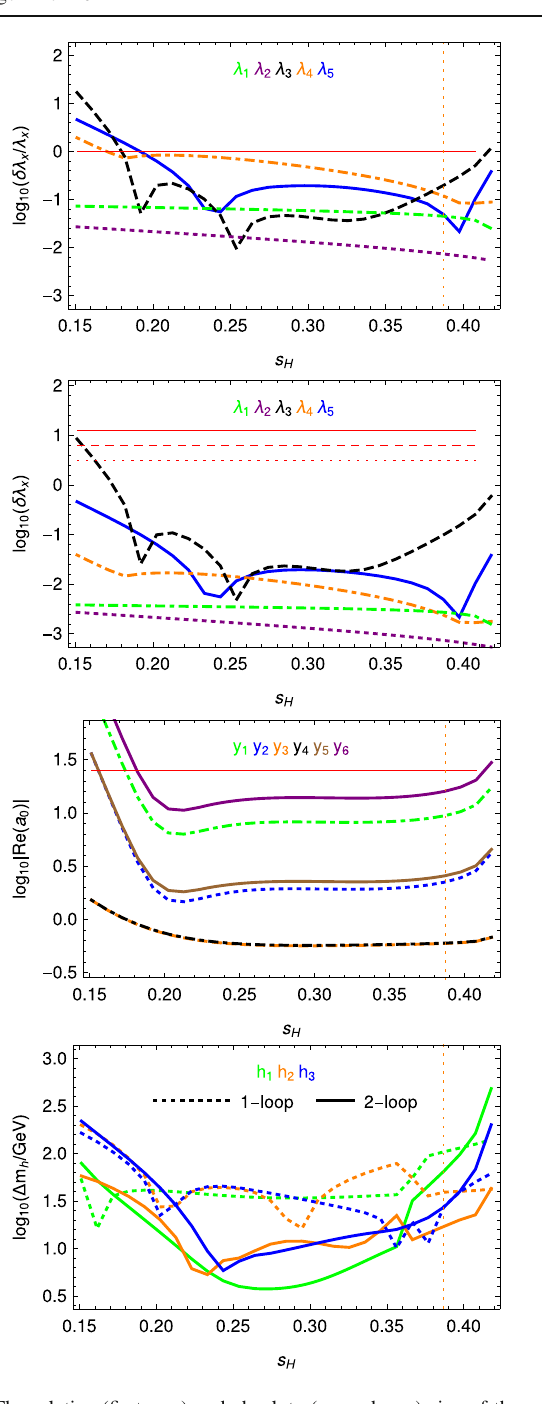
tic CT, i.e. | δλ | < 2 π and | δλ | < 4 π result in approximately the same